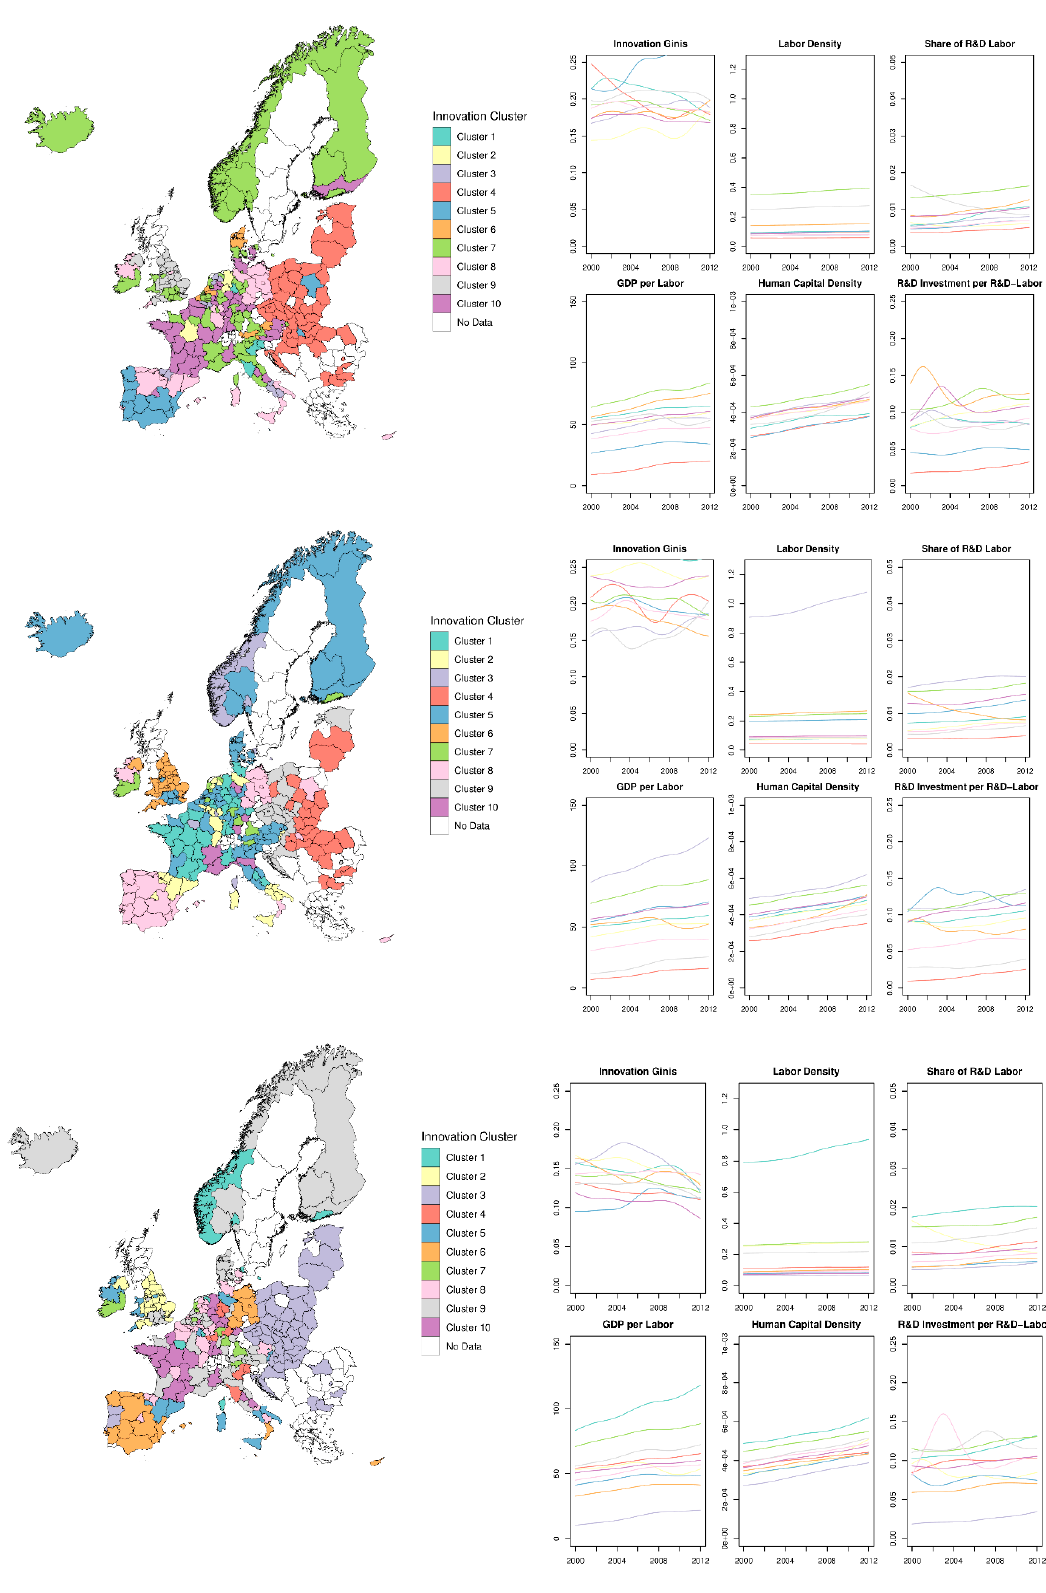
Figure 1. Results of the mixture model-based multivariate functional clustering algorithm. Rows: IPC classes A, B, and C. (A: ‘human necessities’; B: ‘performing operations and transporting’; C: ‘chemistry and metallurgy’). Columns: left: Spatial cluster mapping, right: Temporal cluster dynamics. Source: Own calculations.